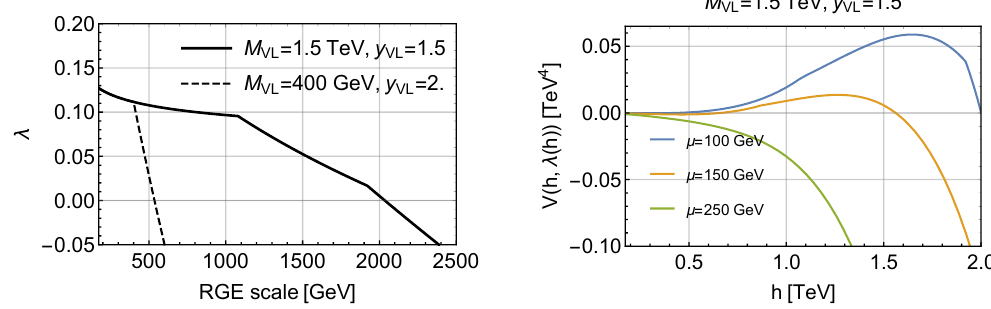
Figure 10 . Two-loop RGE evolution of the Higgs quartic λ (left) and the Higgs potential for varying mass µ in the Higgs bilinear term (right) with the addition of vector-like (VL) doublet and singlet leptons (solid lines) or including only a VL singlet lepton (dashed line).